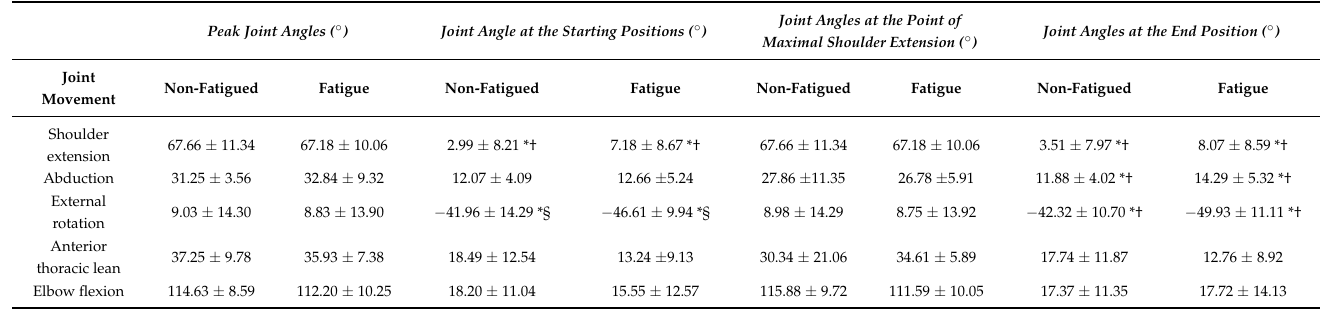
Table 1. Mean ( ± SD) peak joint angles, and joint angles at the starting position, point of maximal shoulder extension, and end position during the bar dip in non-fatigued and fatigued conditions. JointAnglesatthePointof PeakJointAngles( ◦ ) JointAngleattheStartingPositions( ◦ ) JointAnglesattheEndPosition( ◦ MaximalShoulderExtension( ◦ )